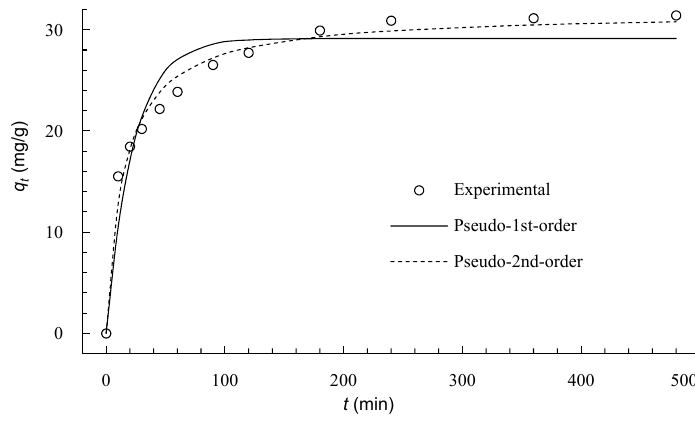
Figure 5. Adsorption kinetics of Cu(II) onto ICSP.